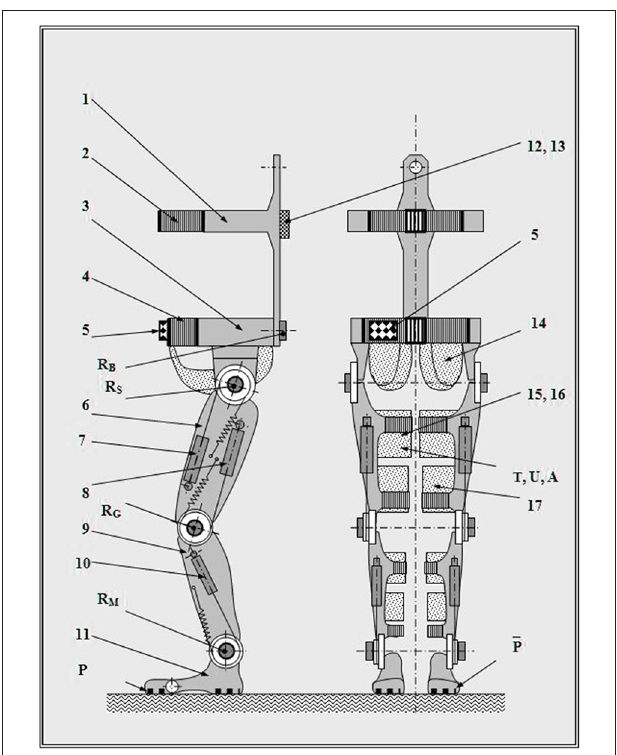
FIGURE 5 | General concept design of the MOD. 1, Back segment; 2, Chest belt; 3, Pelvis segment; 4, Pelvis belt; 5, Programs command box; 6, Thigh segment; 7, Hip actuator; 8, Knee actuator; 9, Ankle segment; 10, Foot actuator; 11, Foot segment; 12, Connections box; 13, Pneumatic connect fitting; 14, Bottom holder; 15, Drawer panty hose; 16, Pulsed air flow textile structure; 17, Attachment belt; R, Angular transducers (B, lumbar sacral; S,